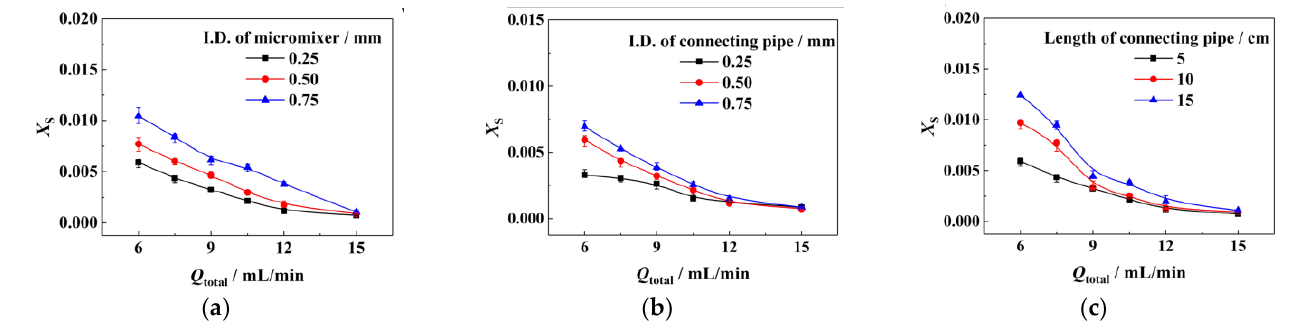
Figure 3. Influence of upstream microstructural elements on micromixing performance: ( a ) I.D. of micromixer, ( b ) I.D. of connecting pipe, and ( c ) length of connecting pipe. Reference conditions: micromixer, 0.25 mm of I.D.; connecting pipe, 0.5 mm of I.D., 5 cm of length; micropacked bed, 10 cm of length; packing size, 0.177~0.250 mm; Q A : Q B = 5:1; μ A = 10 mPa·s and μ B = 1 mPa·s.